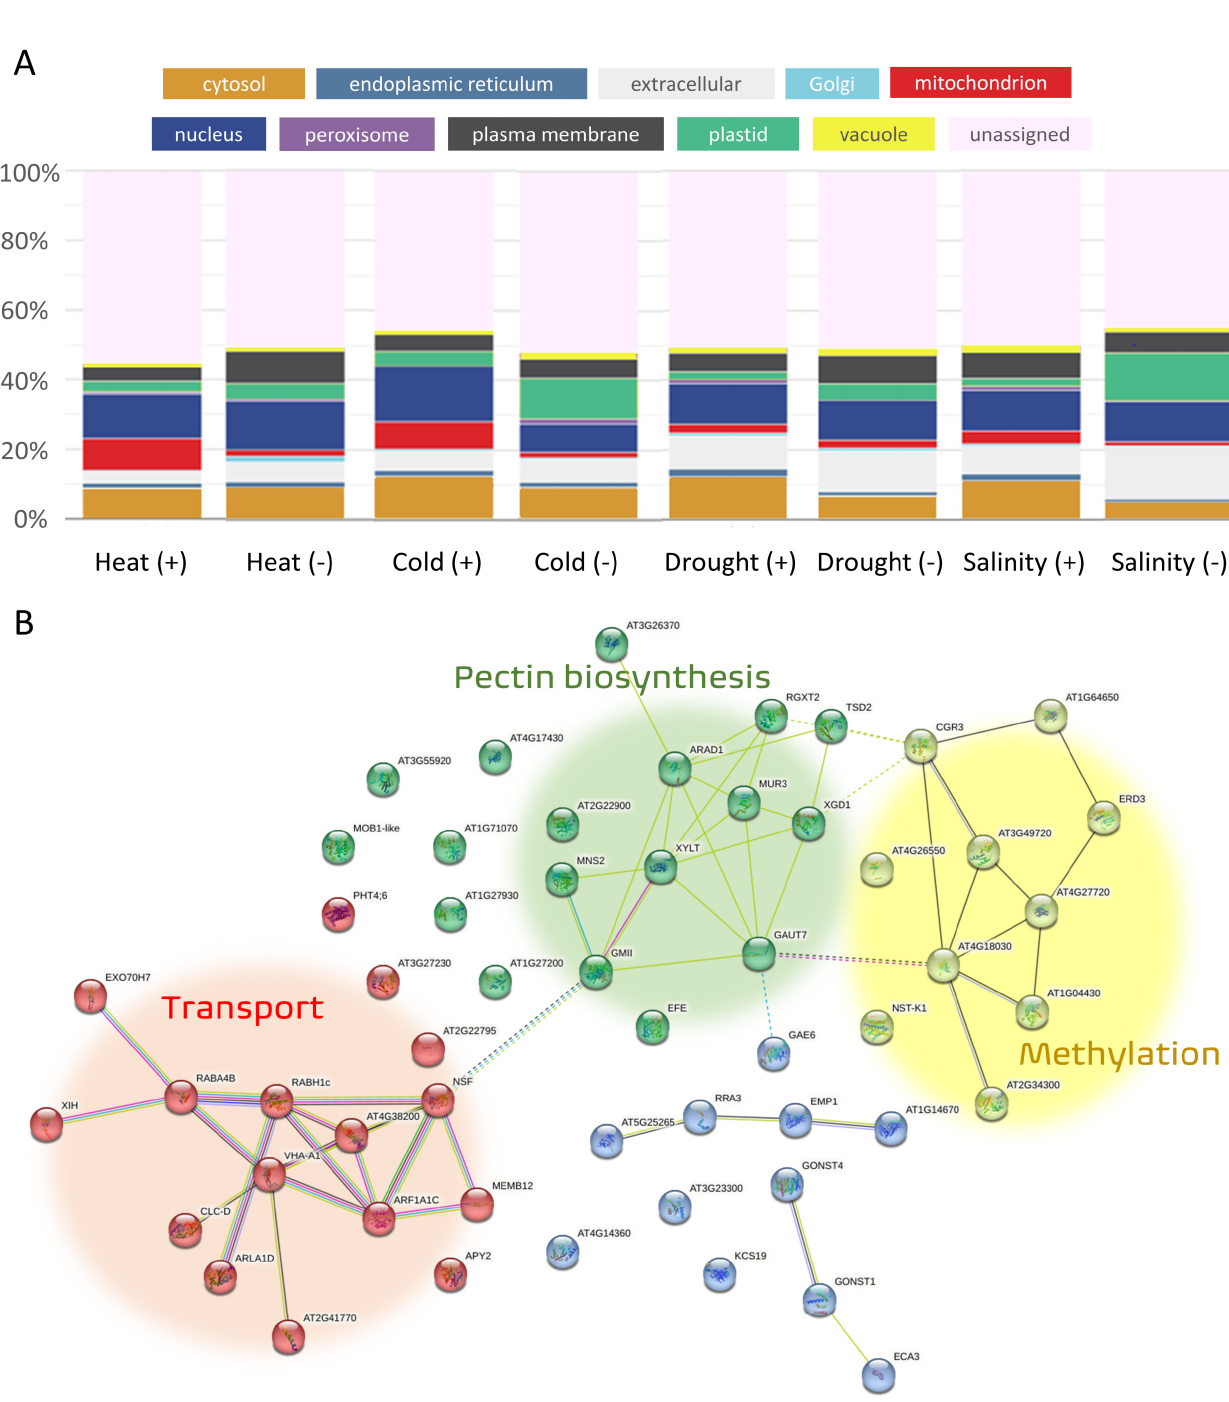
Figure 5. Relative predicted subcellular distribution of stress-responsive gene products calculated for each compartment using the online tool SUBA5 [218]. Data for the analysis were obtained from the Expression Atlas database [203]. ( A ) The genes upregulated by a specific stress are marked as (+) and those downregulated by a specific stress are marked as (-). The bars represent the subcellular distribution of stress-responsive proteins based on the AGI list of stress-regulated genes compared to the HCM list; hits are identified and summed per compartment. ( B ) Heat-stress downregulated genes with localization to the Golgi and their function. The interactions were visualized by String [221].